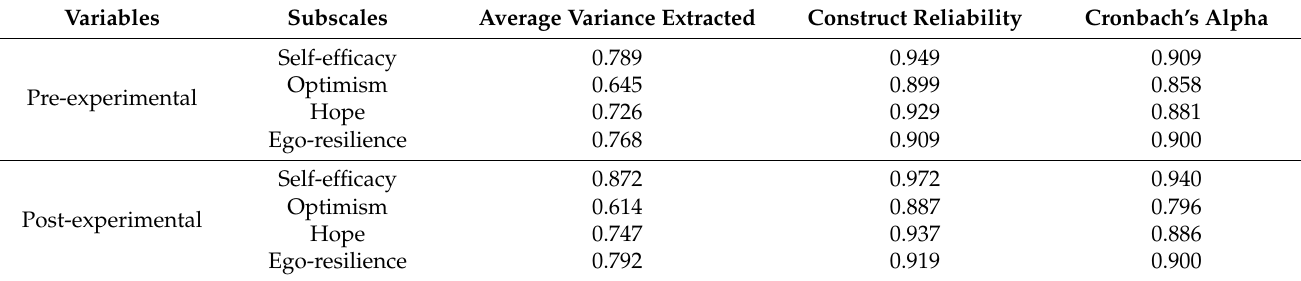
Table 3. Reliability results via Cronbach’s alpha for the positive psychological capital